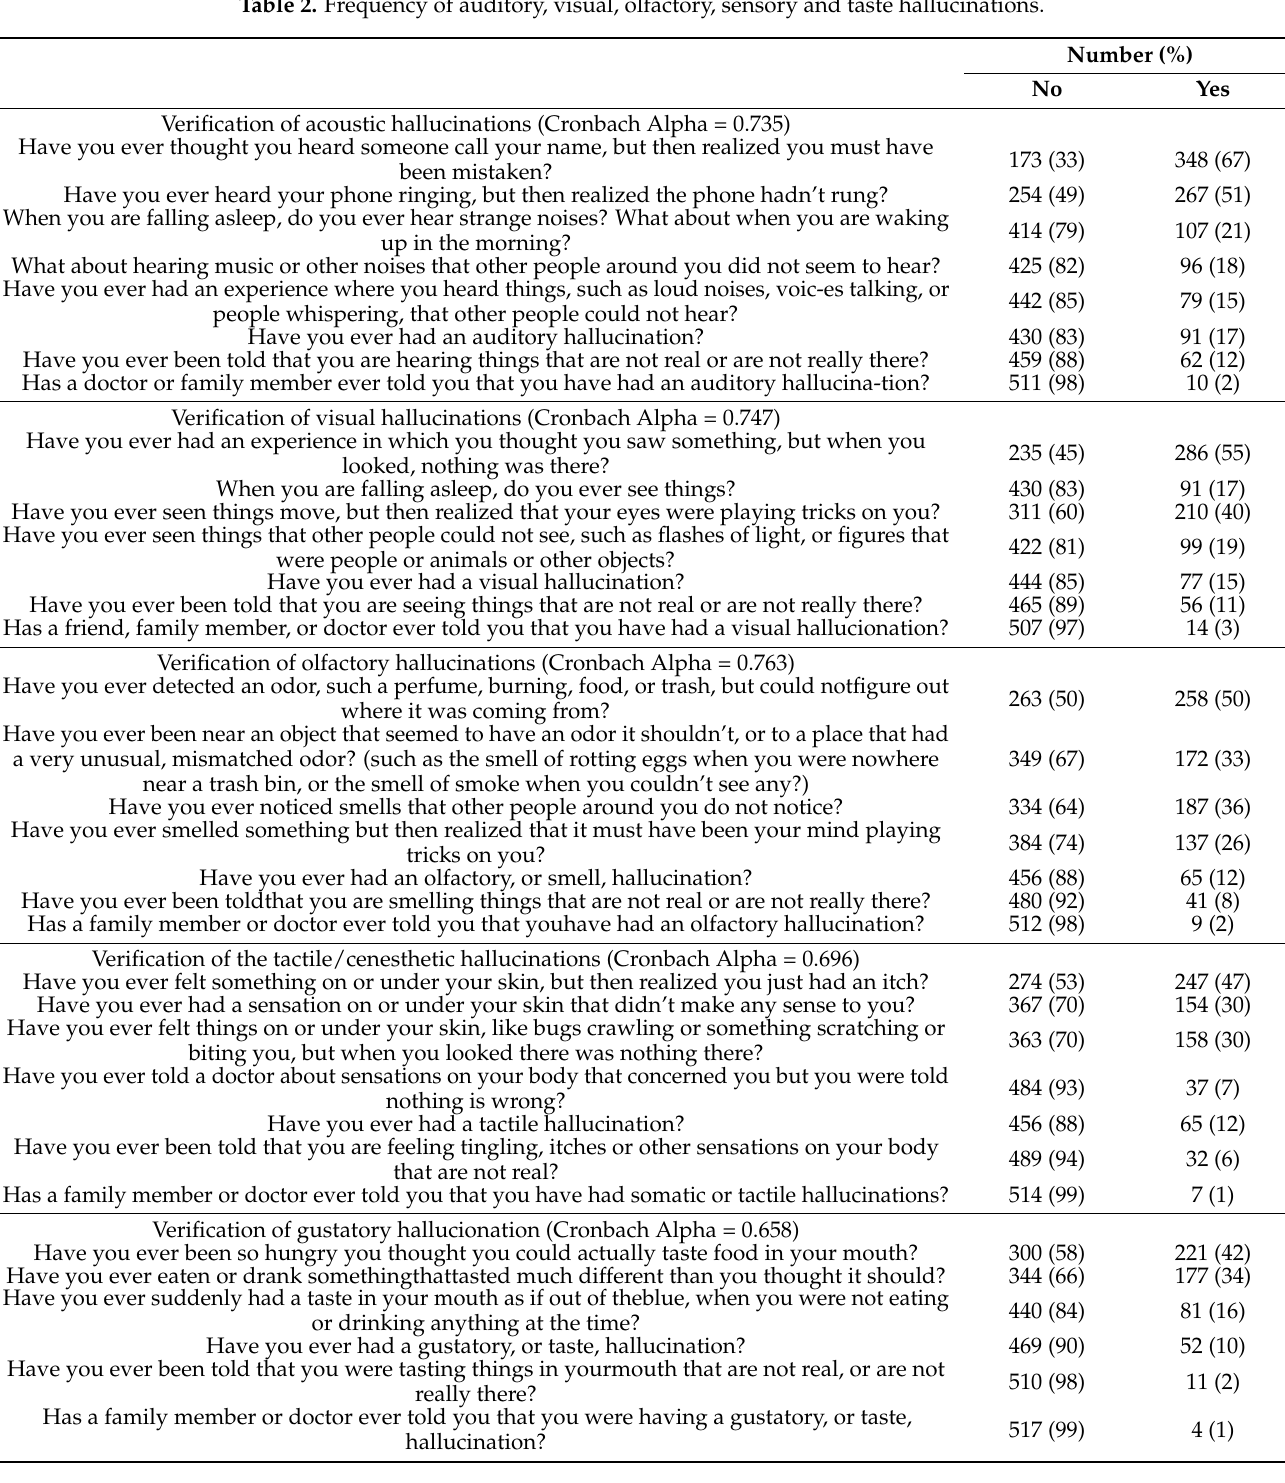
Table 2. Frequency of auditory, visual, olfactory, sensory and taste